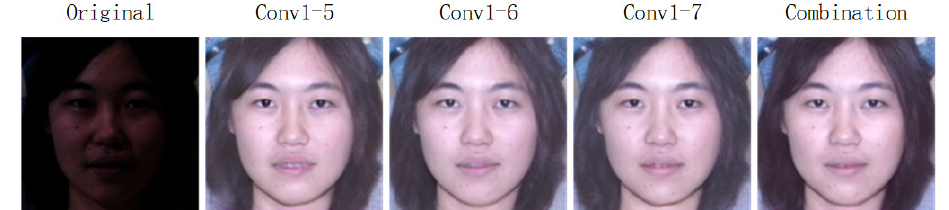
Figure 12. The synthesized results of our method trained under various loss items. Conv1-5 means to use 1 to 5 convolutional layers of VGG-16 for extracting feature and computing loss. Conv1-6 means to use 1 to 6 convolutional layers of VGG-16 for extracting feature and computing loss. Conv1-7 means to use 1 to 7 convolutional layers of VGG-16 for extracting feature and computing loss. Combination denotes to combine the former three loss items for extracting multi-stage feature maps and